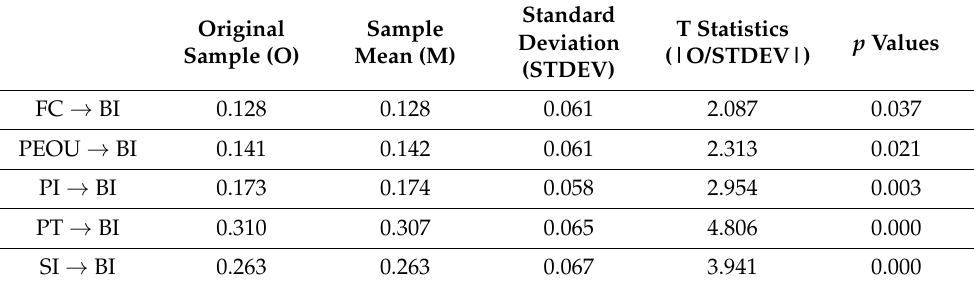
Table 7. Path coefficient